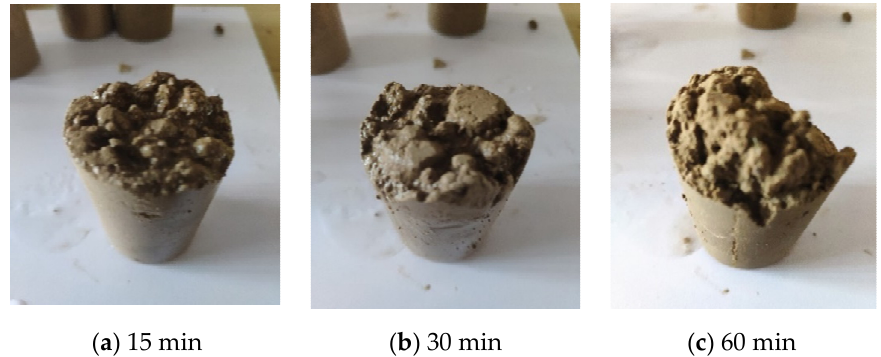
Figure 10. The change of 6% NHL2 hydraulic lime soil with time.